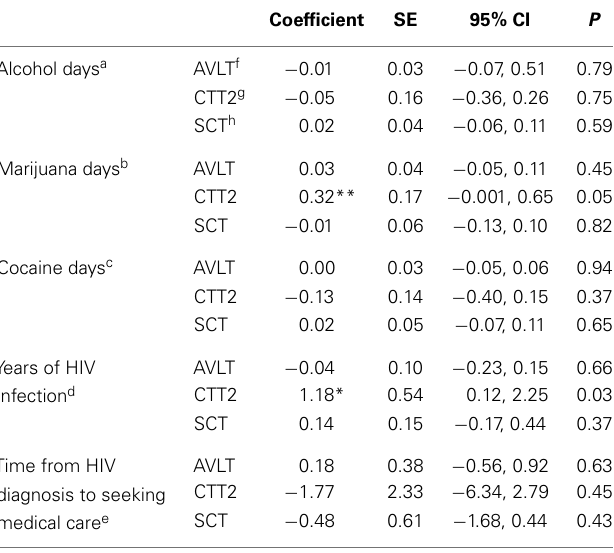
Table 3 | Multivariate, unstandardized path coefficients, standard errors, 95% confidence intervals, and p -values ( N = 370)